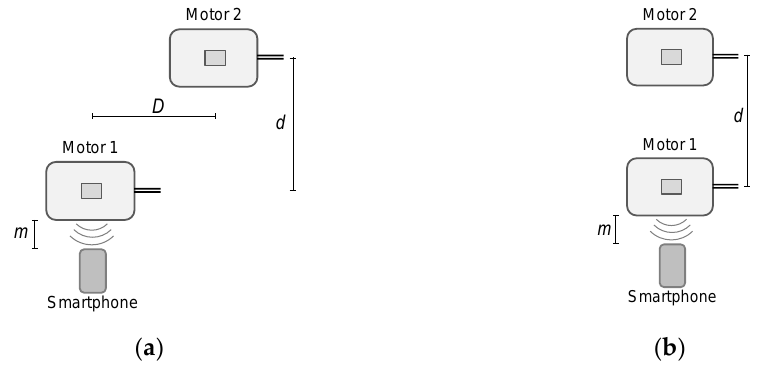
Figure 11. No load coupled to the motor shaft: ( a ) separated motors; ( b ) faced motors. Motor 1 is the reference motor , that is, the motor whose speed is to be estimated. The noise from Motor 2, the background motor , should be discarded as background noise. The values of the distances are d = 1 m, D = 1 m and the distance of the smartphone, m = 5